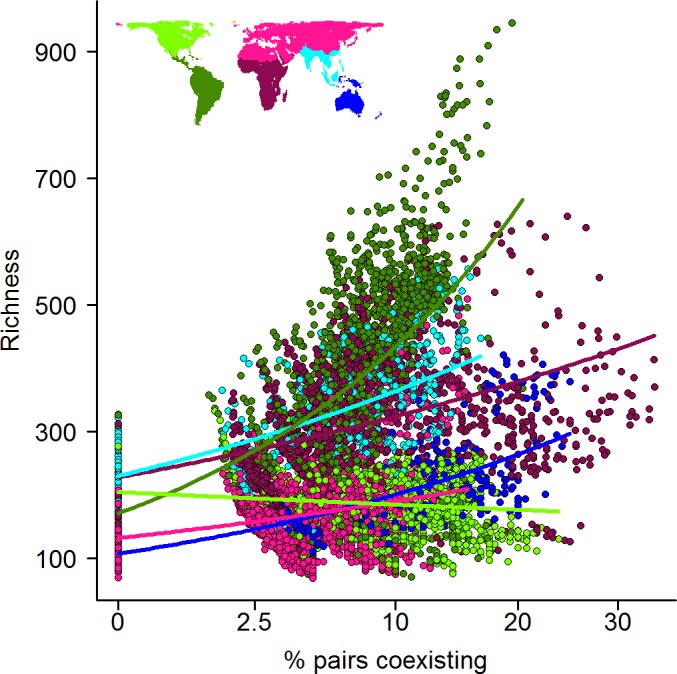
The relationship between the incidence of sister coexistence (%) (n = 1,021 pairs) and the total assemblage richness of all birds (n = 9,993 species).Slopes are from a generalised linear model (GLM) with quasi-Poisson error structure showing the interaction between “Realm” and “Coexistence” (S7 Table). Only cells containing at least 20 sister pairs were used. Line and point colours denote Realm; see map inset. See Dryad depository for cell values [52].